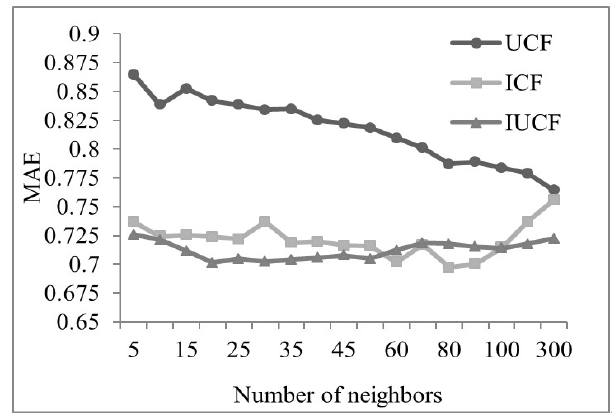
Figure 4. Comparison of the changes in MAE with the number of neighbors.